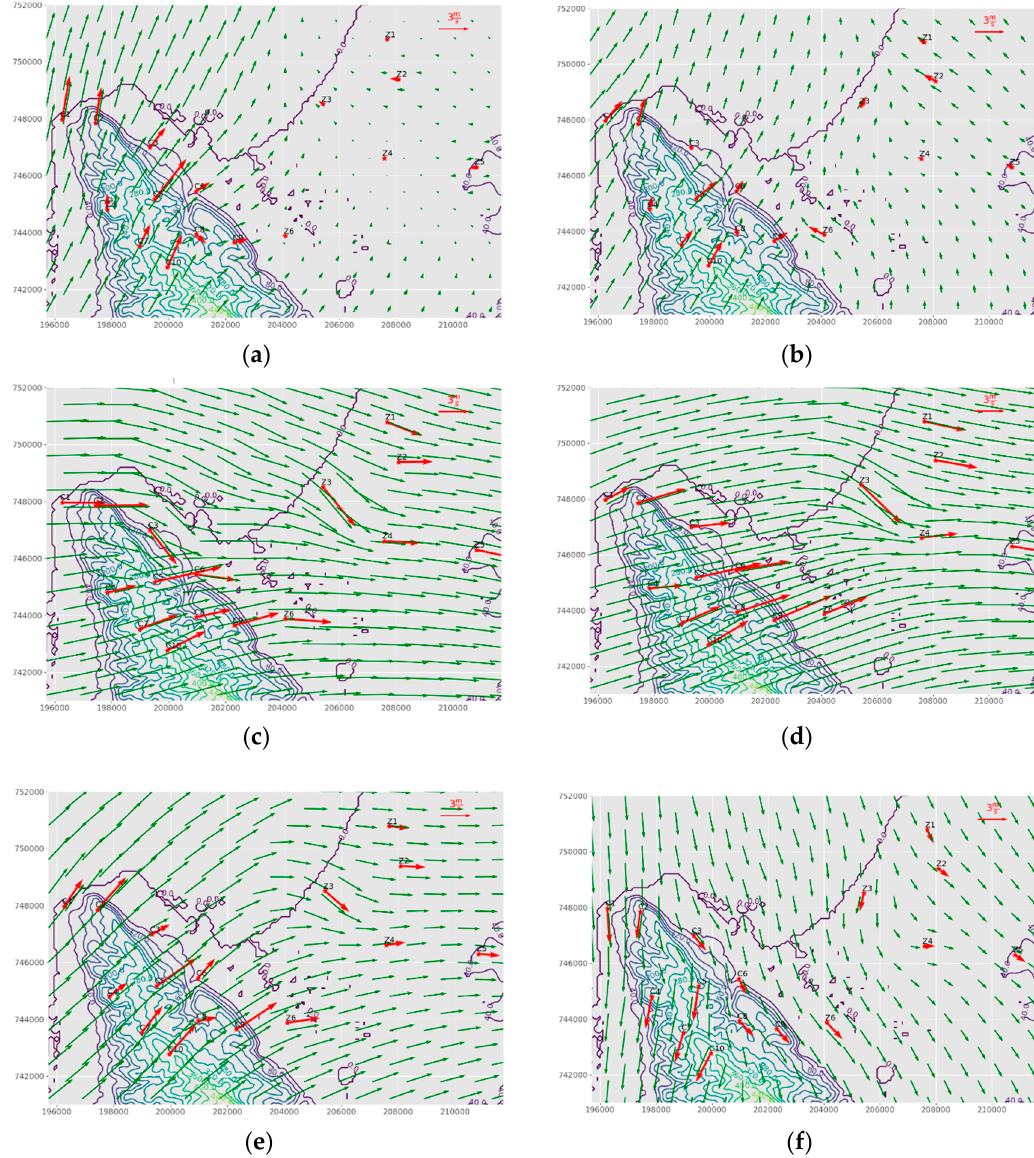
Figure 2. Characteristic examples of the spatial wind field in the Carmel Mountain and Haifa bay area in two representative days (colored contours represent different topographical height). ( a , c , e ) 4 August 2015 ( b , d , f ) 15 August 2015. Panels ( a , b ) describe 0400 h as representing the night time; ( c , d ) describe 1400 h which represents the daytime and ( e , f ) describe 2000 h that represents the evening. All time points are in LST (UTC+2).